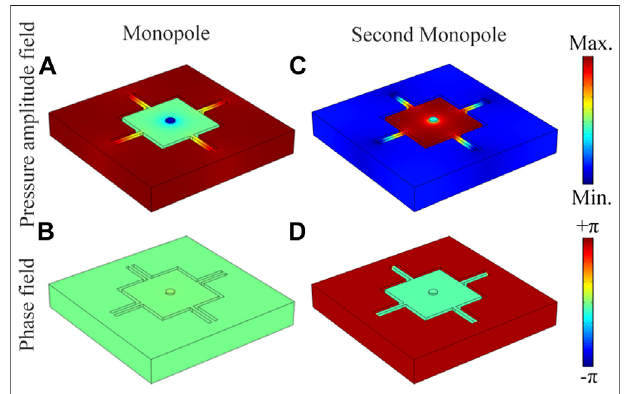
FIGURE 2 | Simulated pressure amplitude and phase eigenfunctions of Mie resonance modes of the unit for (A) , (B) monopole at 238.4 Hz and (C) , (D) second monopole at 1,145.4